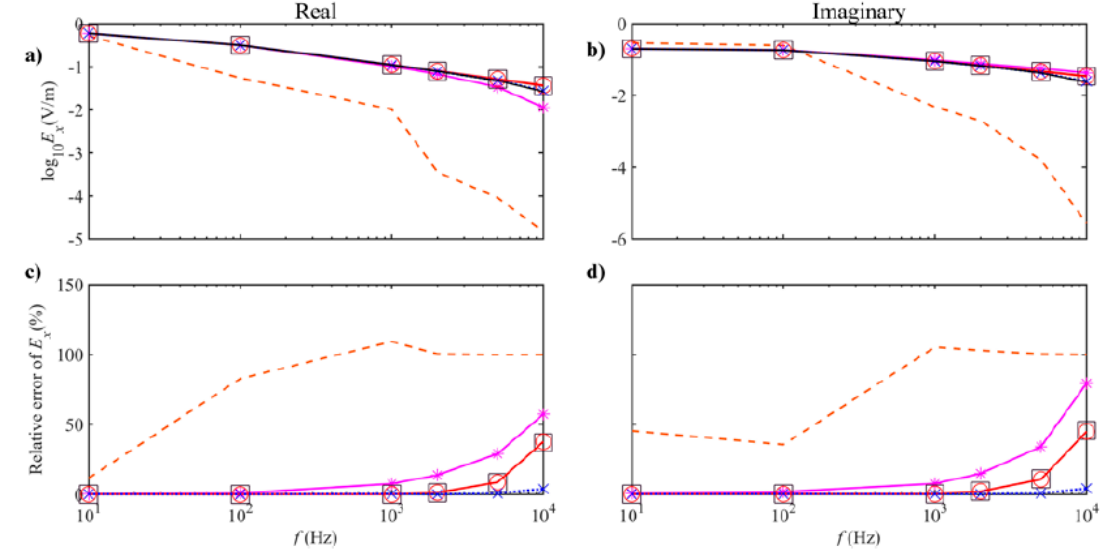
Figure 2. Comparison of the E x solutions from cases based on the quasi-static approximation with 10 − 4 (orange dashed lines), 10 − 6 (purple asterisk lines), 10 − 8 (dark green square lines), and 10 − 10 S / m (red circle lines) for air conductivity, and the one with the complete wavenumber (blue dotted cross lines) along with the analytical solution (solid lines) for model I. ( a ) the real part and ( b ) the imaginary part of E x are indicated, and the relative errors of ( c ) the real partand ( d ) the imaginary part of E x are indicated .